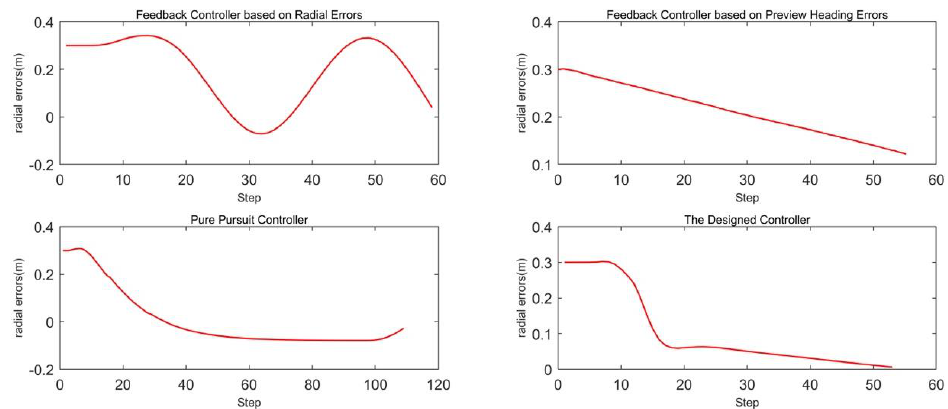
Figure 10. Radial error comparison during the simulation.